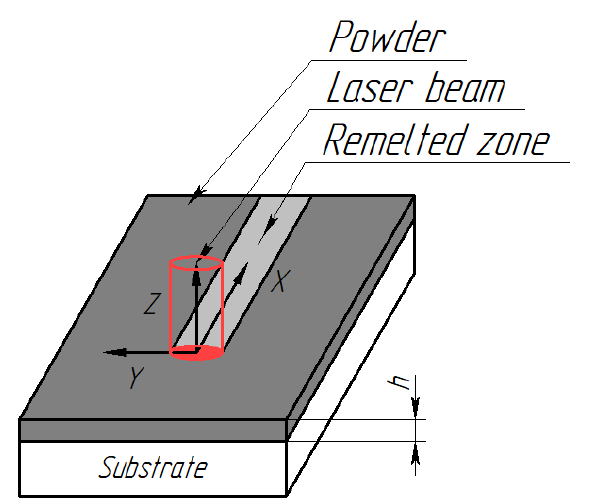
Fig. 1. Scanning process